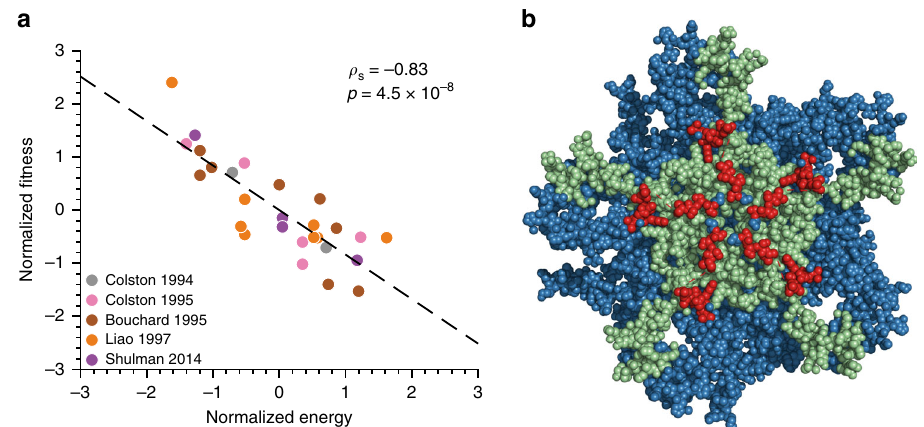
Fig. 5 Biological validation of the inferred fi tness landscape of vp1. a In silico-predicted energy obtained from the prevalence landscape inferred from the sequences corresponding to peak 1 correlates highly with the experimental fi tness measurements. Replicative fi tness data was obtained from literature 45,48 – 50,70 and is presented in Supplementary Table 2. The black dashed line represents a linear least-squares fi t to guide the eye. b A large proportion of the top 1 percentile model couplings are involved in forming a critical vp1 – vp4 interface. The vp1 and vp4 pentamers are shown as sets of blue and green spheres, respectively, while the vp1 residues in both the top 1 percentile model couplings and in the critical vp1 – vp4 interface 55 are shown as red spheres. The crystal structure of the poliovirus capsid was downloaded from the PDB database, https://www.rcsb.org/ (ID: